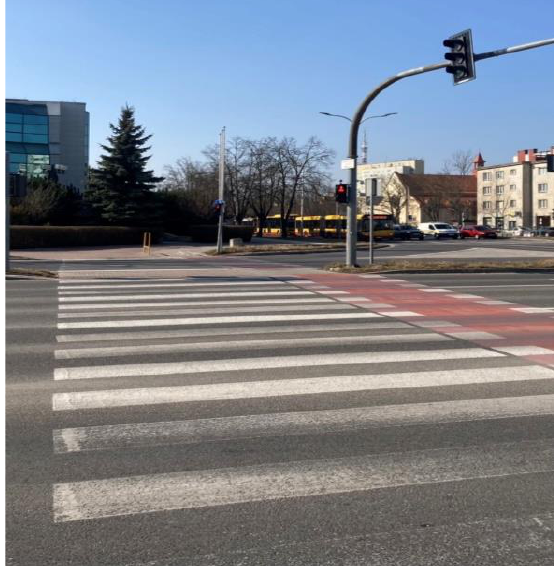
Figure 12. Observation site: pedestrian crossing number 4.